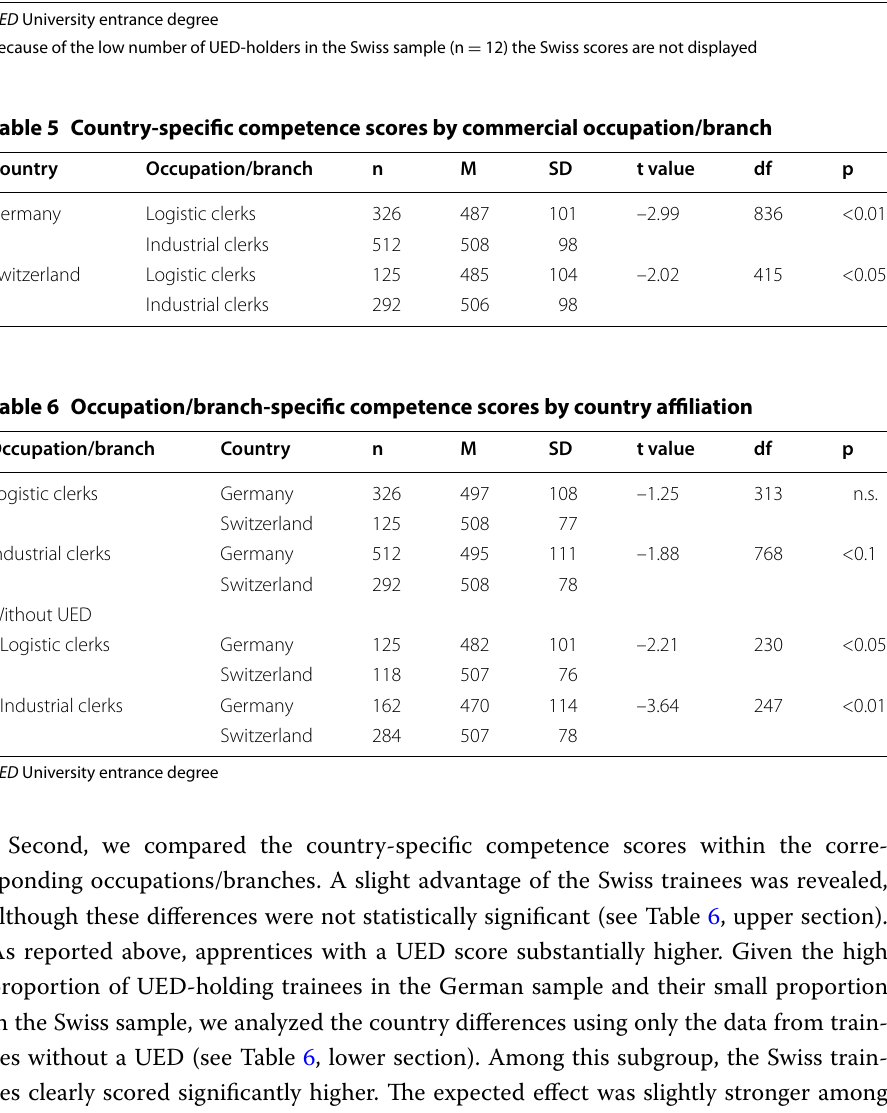
UED University entrance degree